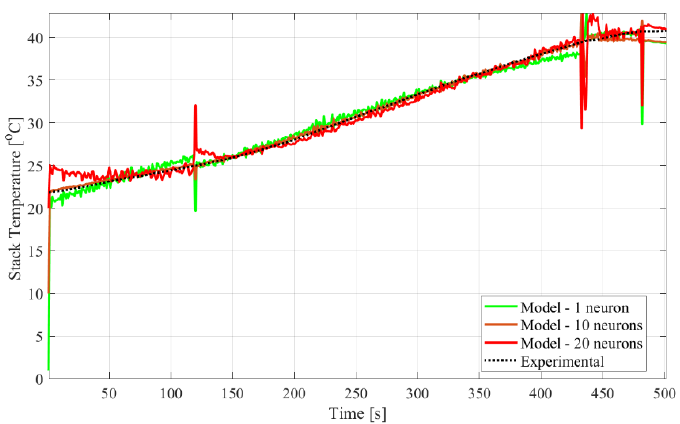
Figure 11. Experimental and model responses of the stack temperature using an ANN with the SCG algorithm. Table 2. Statistical analysis of the model results for the stack voltage.